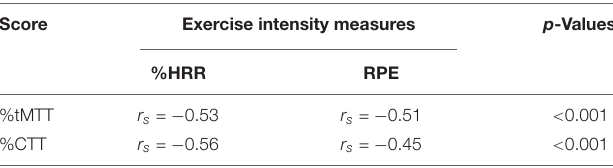
TABLE 2 | Correlation coefficients ( r s ) between estimated exercise intensity based on respective percentages of tMTT and CTT against the %HRR and RPE. Score Exercise intensity measures p